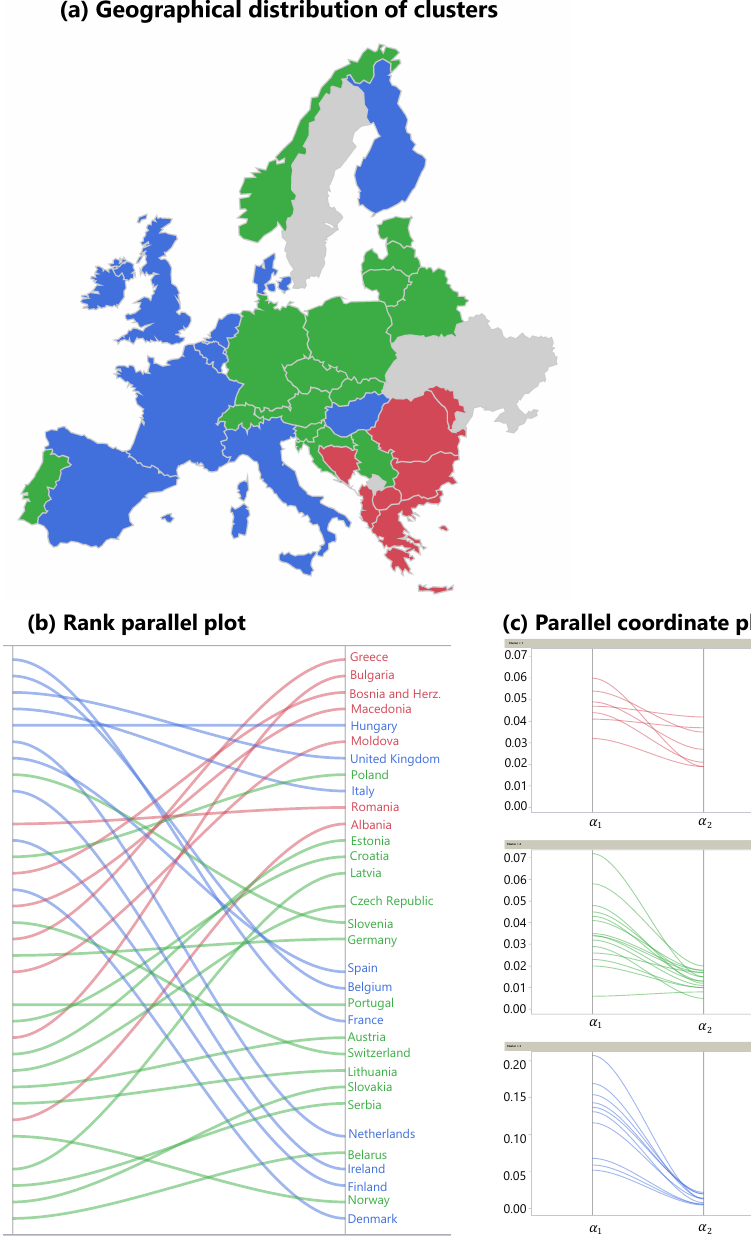
Figure 2. Graphical representations of the clustering. The three clusters were determined using the four parameters ( α 1 , α 2 , p 2 rel , ∆ r ) deduced from the time series analysis. ( a ) Although these parameters did not contain any geographical information, the clusters represent different regions in Europe. The parallel plot of the α -ranks shows that the first cluster (red, southeast Europe) was characterized by low cCFRs in the first wave and high values in the second wave (compared to the rest of Europe). The third cluster (blue, western Europe) exhibited an opposite pattern. In the second cluster (green, central Europe), low cCFRs in the first wave were followed by slightly higher cCFRs in the second wave. In grey: countries not attributable to a particular cluster. ( b ) Overall, the rank plot shows evidence of the flip effect: in nearly all countries, the α -rank changed. ( c ) Absolute values of α 1 and α 2 of the three clusters. Note that these values are standardized for the clustering